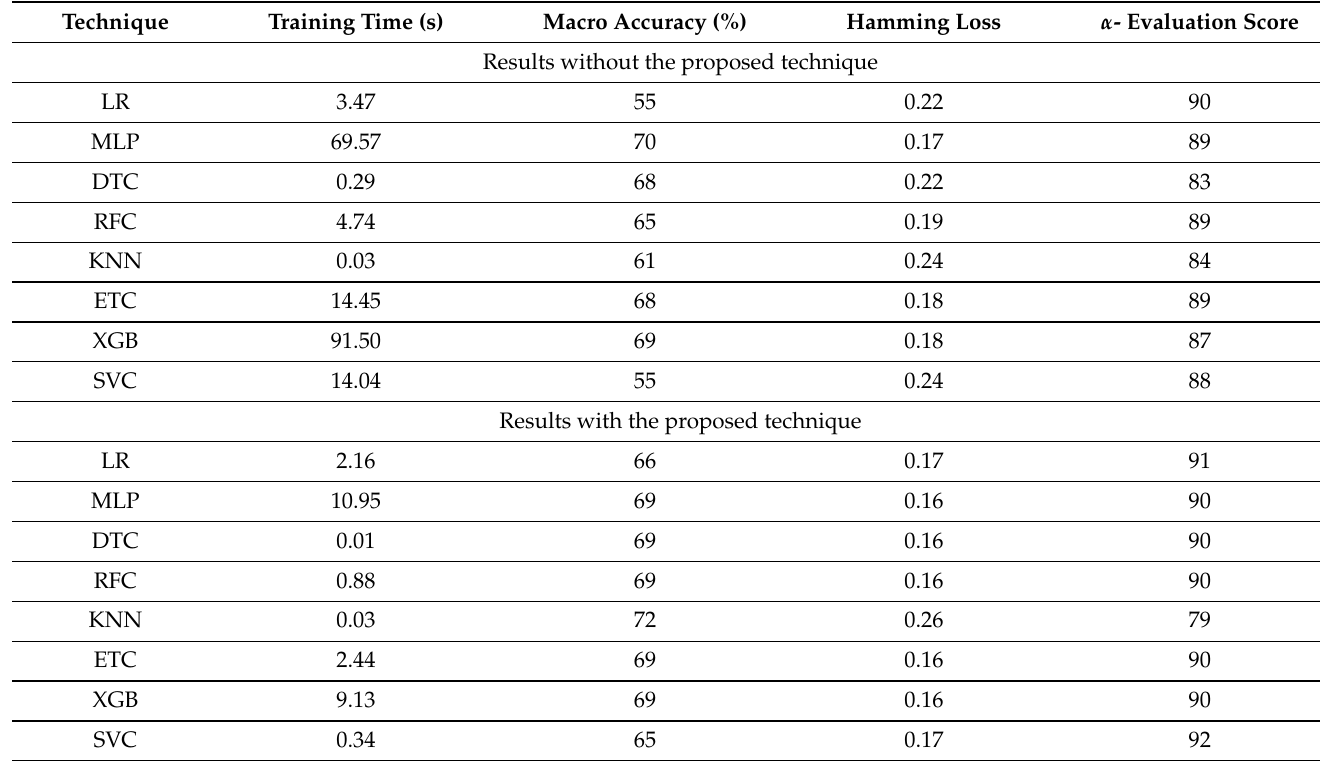
Table 7. The multi-label multi-class performance comparative analysis with an imbalanced dataset using a data split of